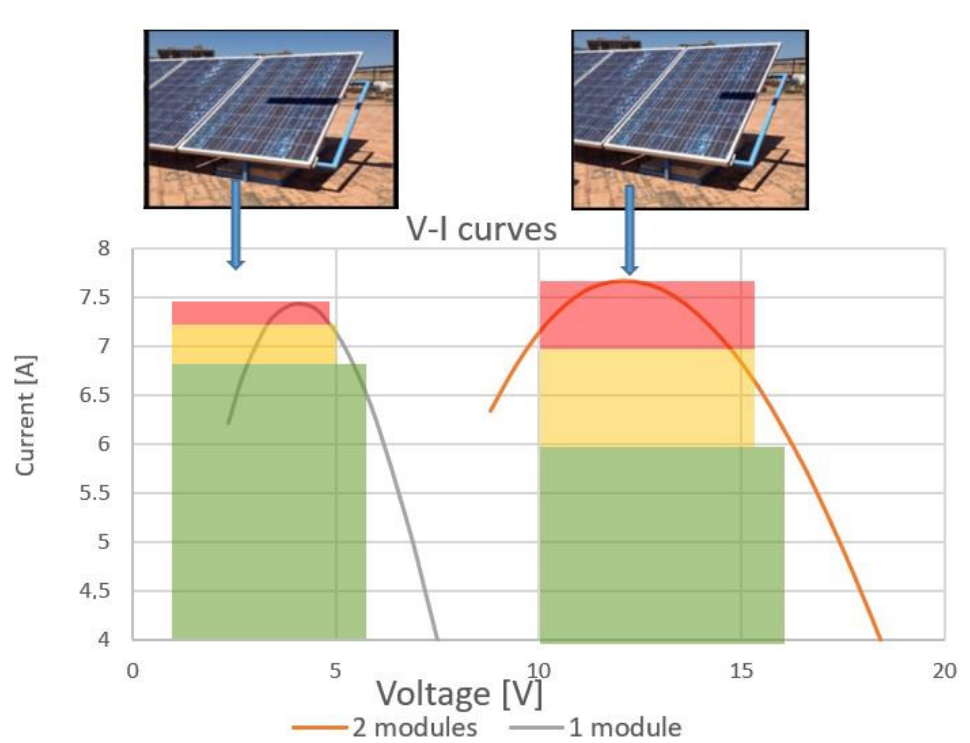
Figure 11. Zones of convenience of the disconnection of shaded module. Table 12. Characteristics in di ff erent load conditions evaluated by reconfigurator for each